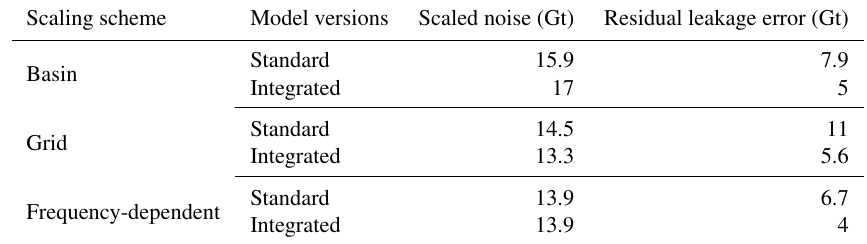
Table 9. Scaled noise and residual leakage in scaled GRACE basin-averaged time series of Indus